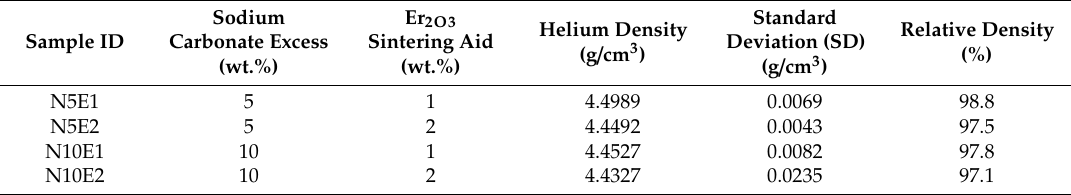
Table 2. Density of hot pressed KNN with Er 2 O 3 addition.